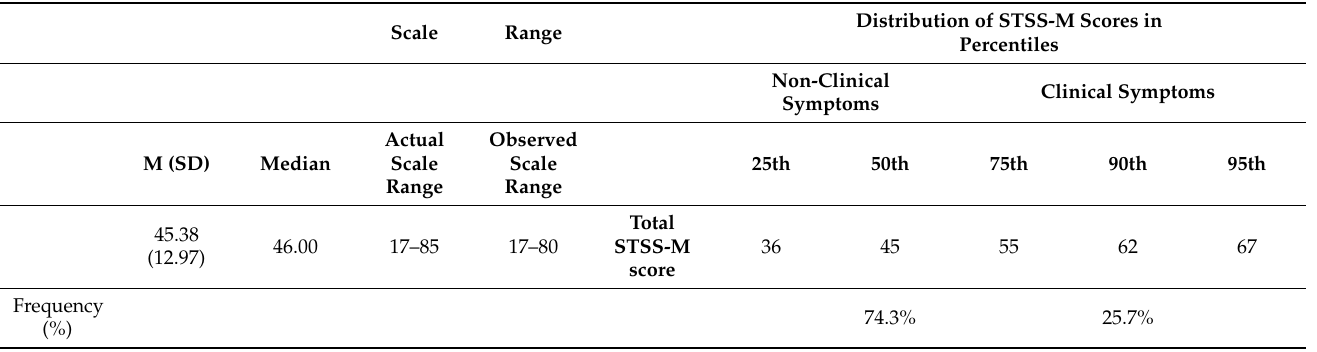
Table 3. The mean, median, standard deviation, scale range and frequency of responses in each percentile of the total STSS-M score (N = 233).